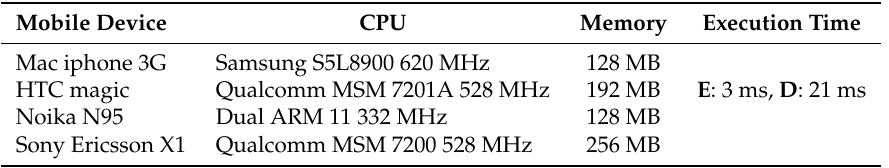
Table 4. Some popular mobile